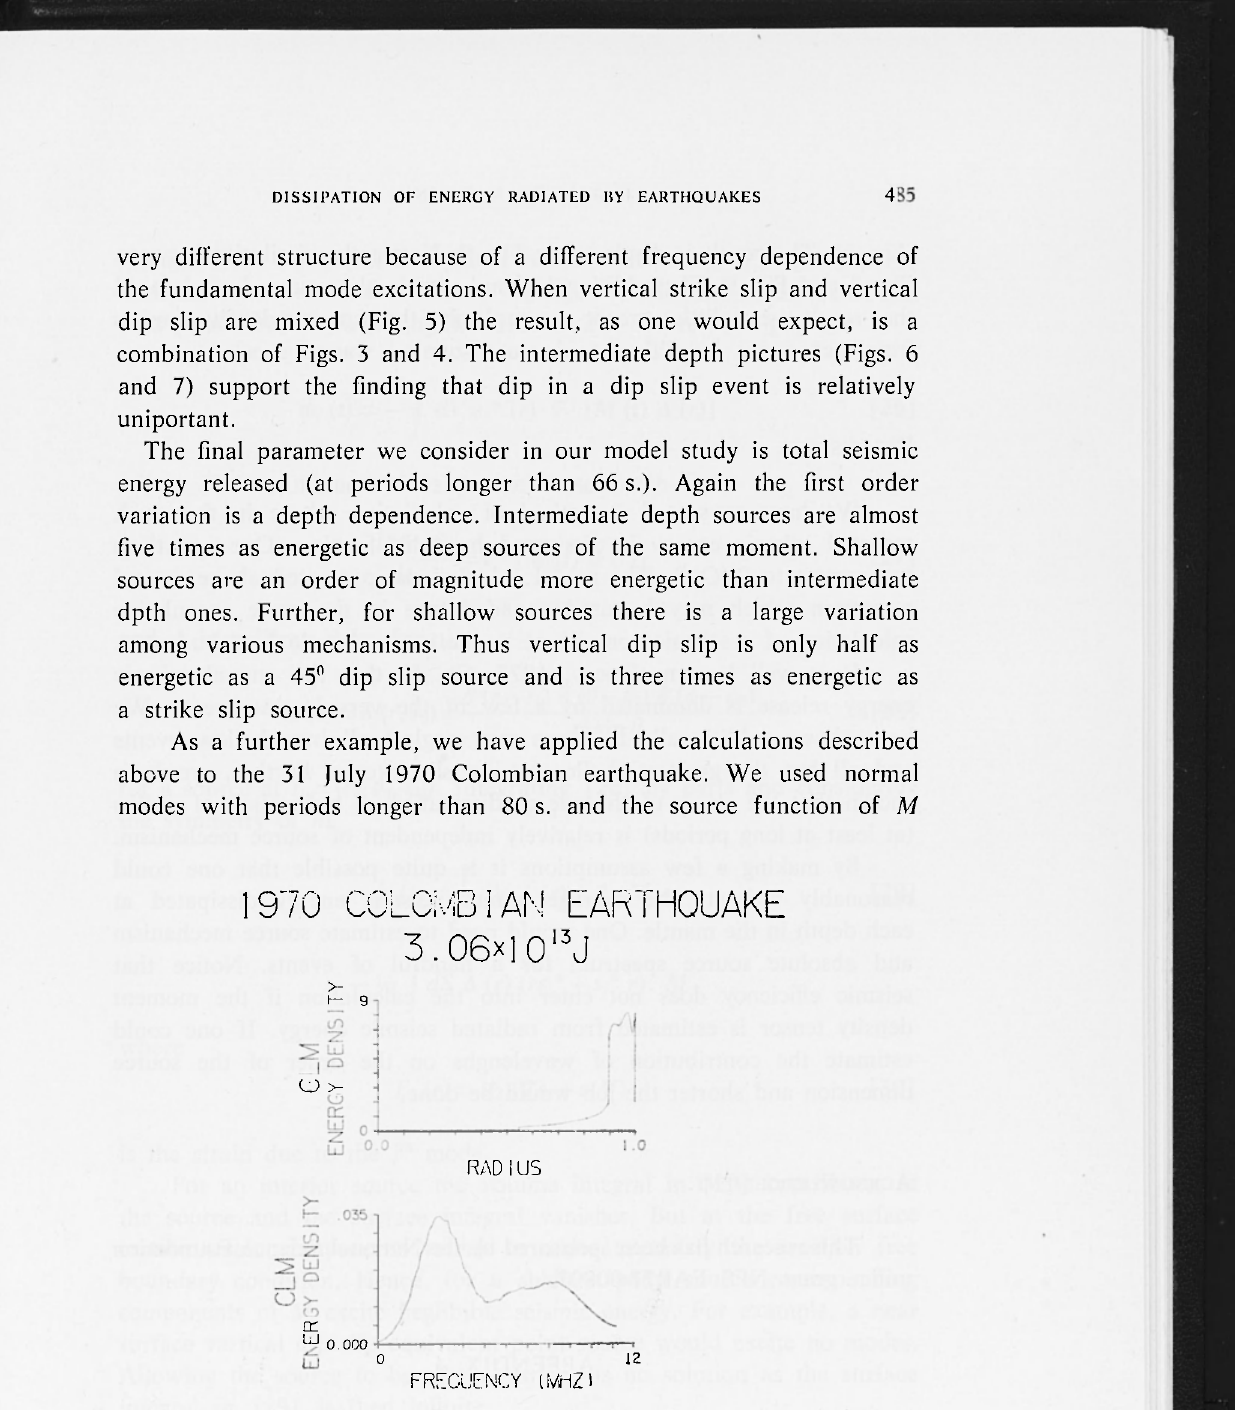
Fig. 9. (top). Energy density as a function of radius of the earth and (bottom) smoothed energy density as a function of frequency for the 31 July 1970 Colombian source of M (Fig.